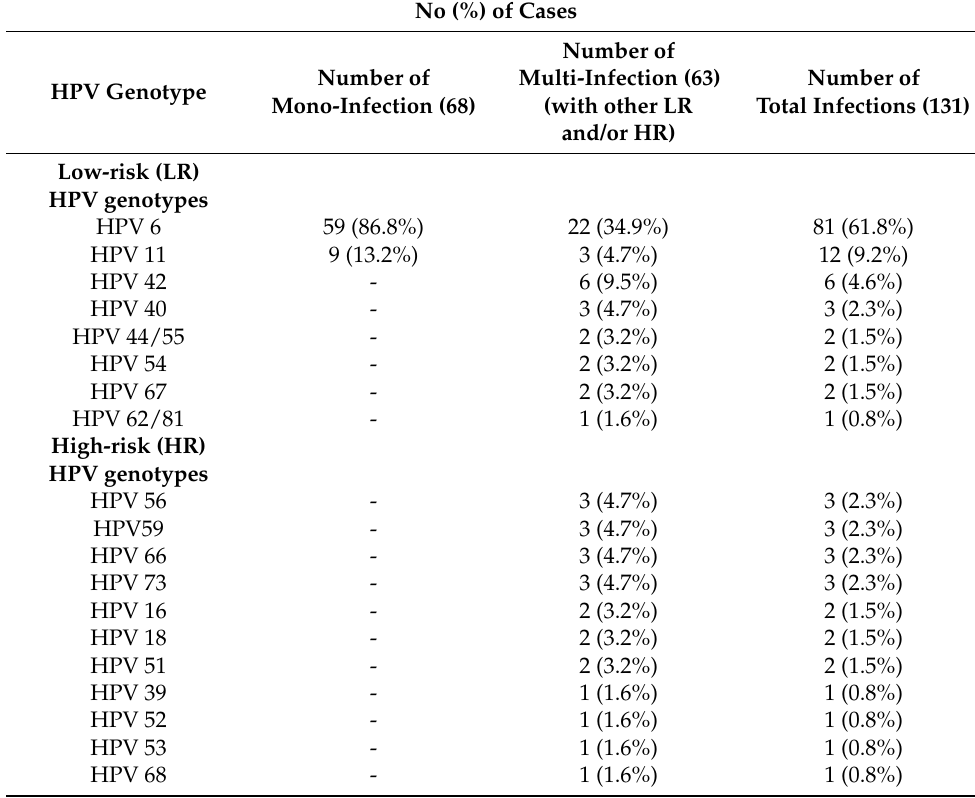
Table 3. Prevalence of human papillomavirus (HPV) genotypes and infection numbers among ninety- four patients diagnosed with external anogenital warts (EGW), by decreasing order of